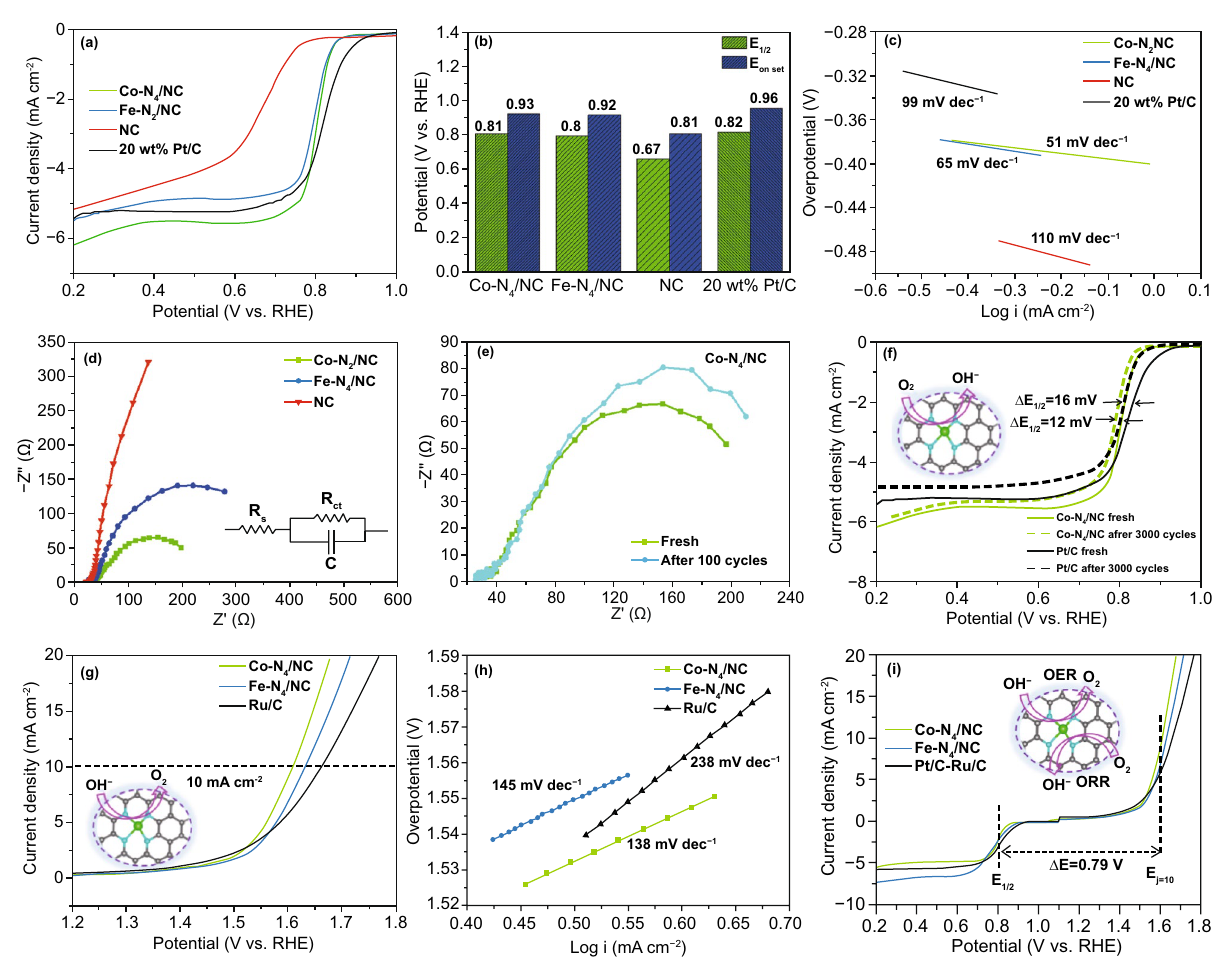
Fig. 6 a Linear scan voltammetry (LSV) curves, b Half-wave potential and onset potential and, c Tafel slopes of Co-N 4 /NC, Fe-N 4 /NC, NC, and Pt/C for ORR in